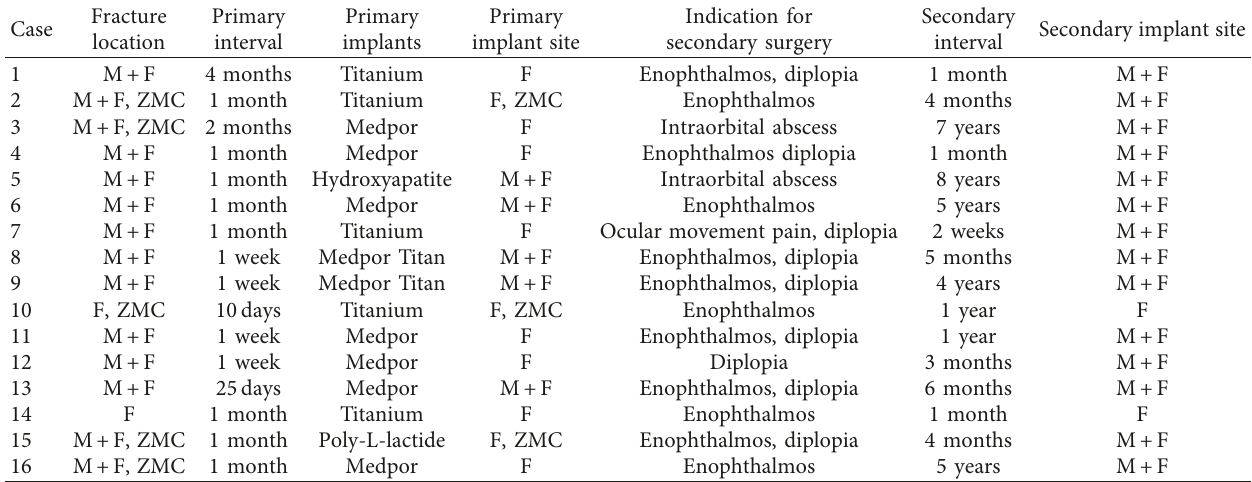
Table 1: Patient demographics.